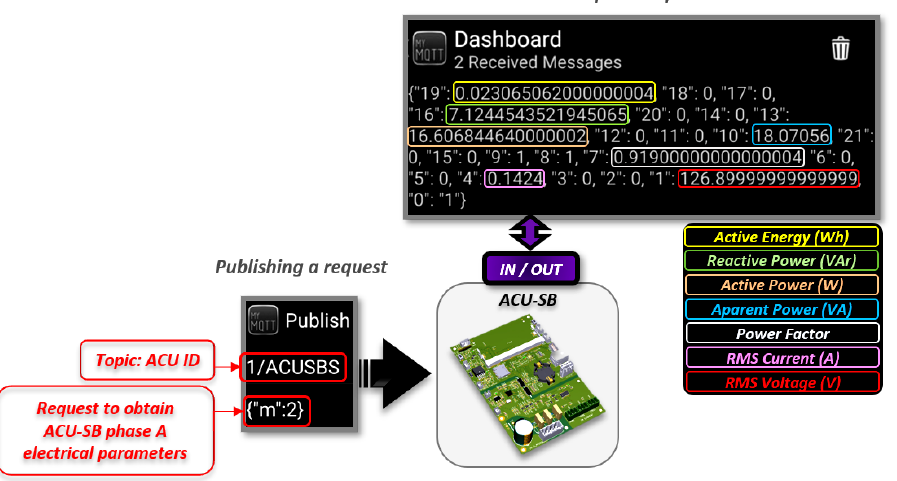
Figure 18. Collecting electrical parameters of A-phase through the